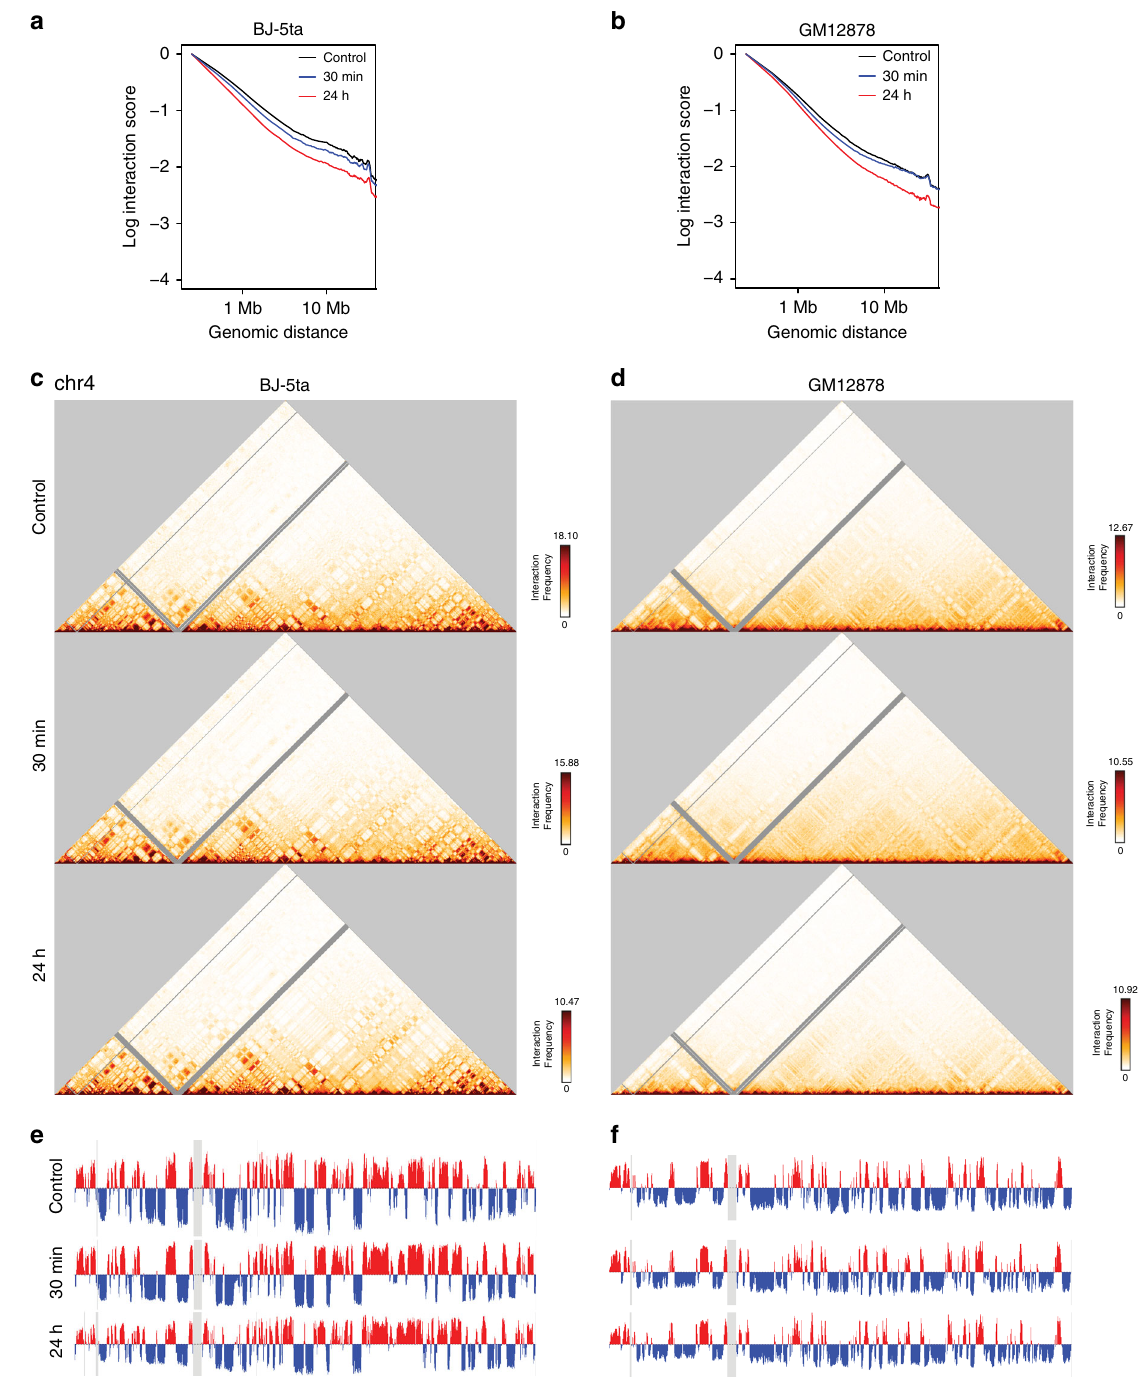
Fig. 3 Loss of distal contacts, compartment maintenance after IR. a, b Scaling plots showing average decay of contacts with distance across all chromosomes at a 250 kb bin size in BJ-5ta ( a ) or GM12878 ( b ) cells for control, 30 min post-IR, and 24 h post-IR. c , d 250kb binned Hi-C interaction heatmaps for chromosome 4 in BJ-5ta ( c ) and GM12878 ( d ) cells in control (Top), 30 min post-IR (Middle), and 24 h post-IR (Bottom). e, f Plots of the fi rst eigenvector from principal component analysis of chromosome 4 in BJ-5ta ( e ) and GM12878 ( f ) cells in control (Top), 30 min post-IR (Middle), and 24 h post-IR